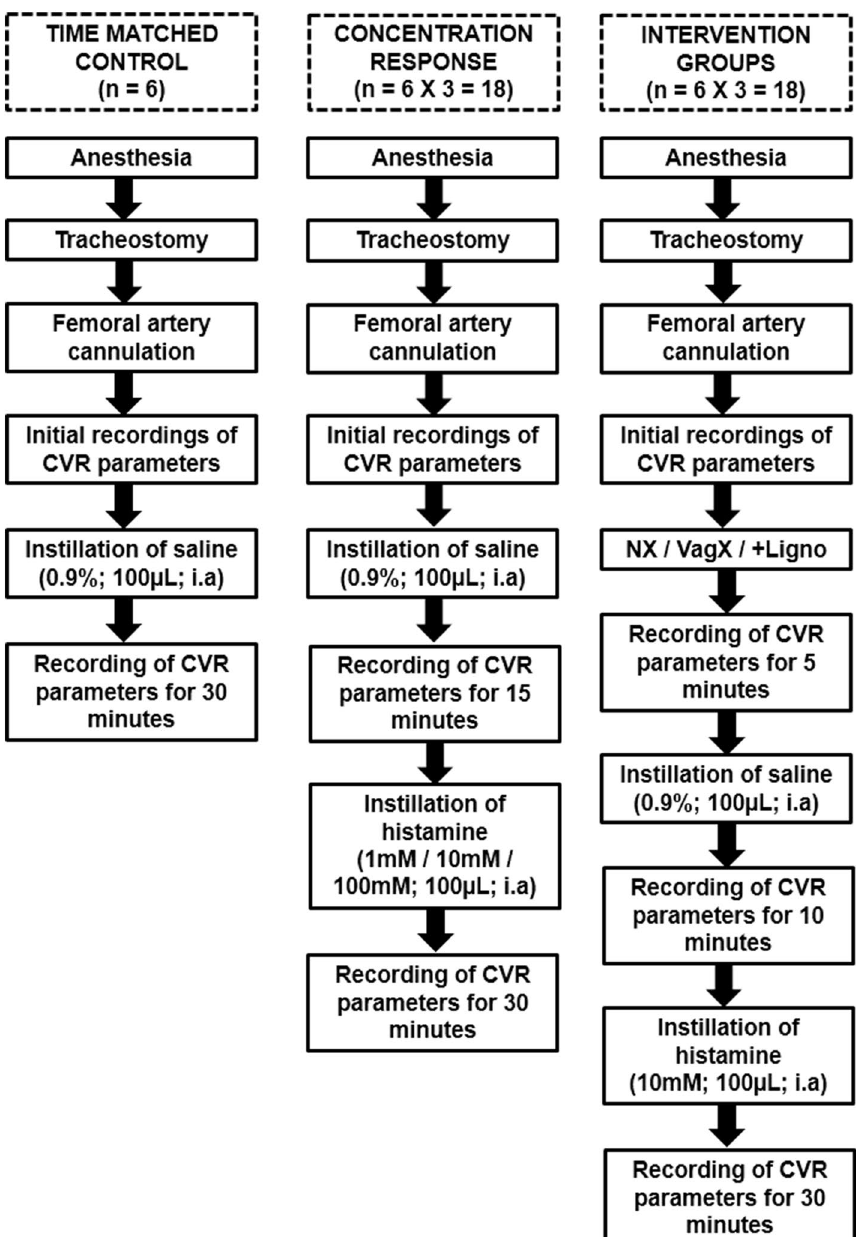
Figure 1. Flowcharts illustrating the experimental protocol. In the first part of the study, normal saline was instilled into the femoral artery and the cardiorespiratory (CVR) responses were recorded. In the second part of the study, histamine in three different concentrations was instilled in different groups of rats and the CVR responses were recorded. In the third part of the study, 10 mM of histamine (optimal dose from concentration– response experiments) was instilled intra-arterially (i.a) after ipsilateral sciatic and femoral neurotomy (NX), bilateral vagotomy (VagX) and pre-treatment with lignocaine (+Ligno) in different groups of rats and the CVR responses were